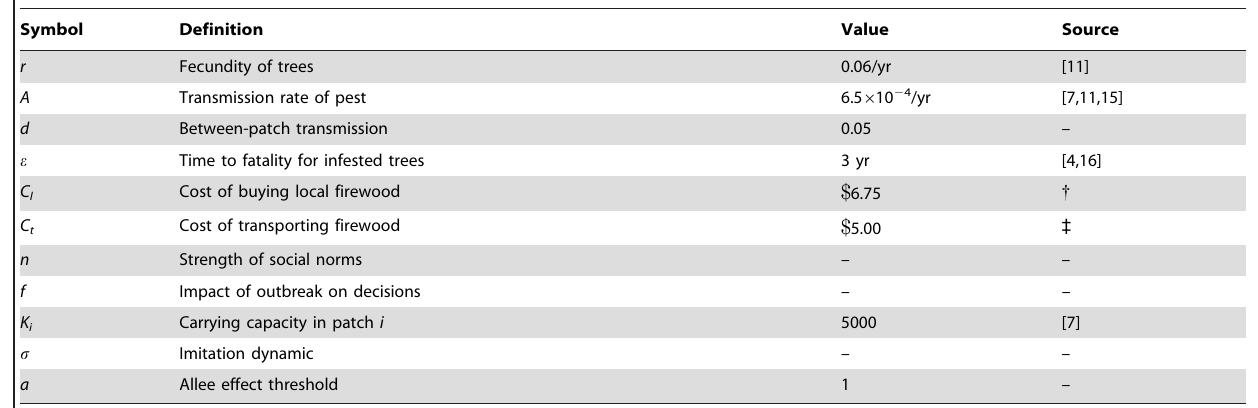
Table 1. Parameter definitions and